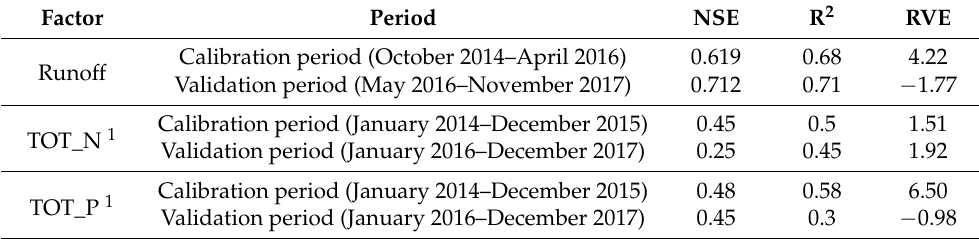
Table 2. Statistic of evaluation indices of the SWAT model. NSE: Nash–Sutcliffe efficiency; RVE: relative volume error. Factor Period NSE R